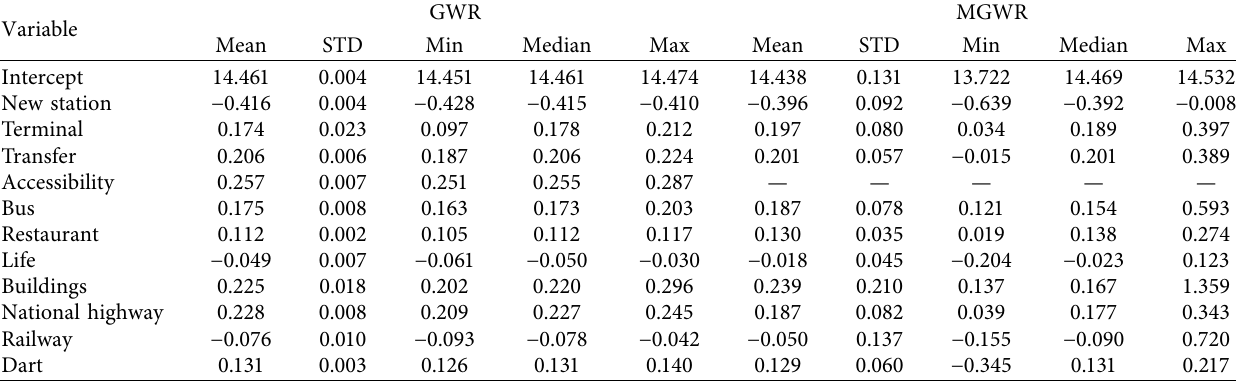
Table 4: Results of GWR and MGWR model.